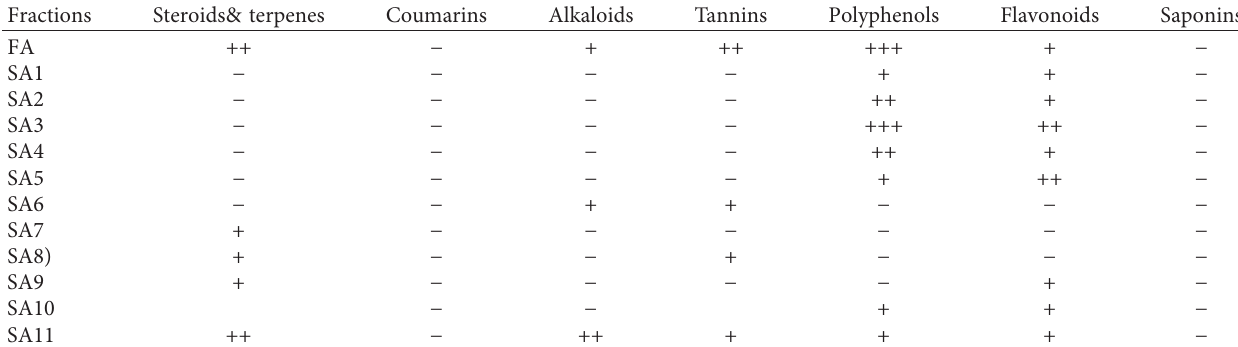
Table 6: Phytochemical screening of the acetone mother extract FA and its fractions